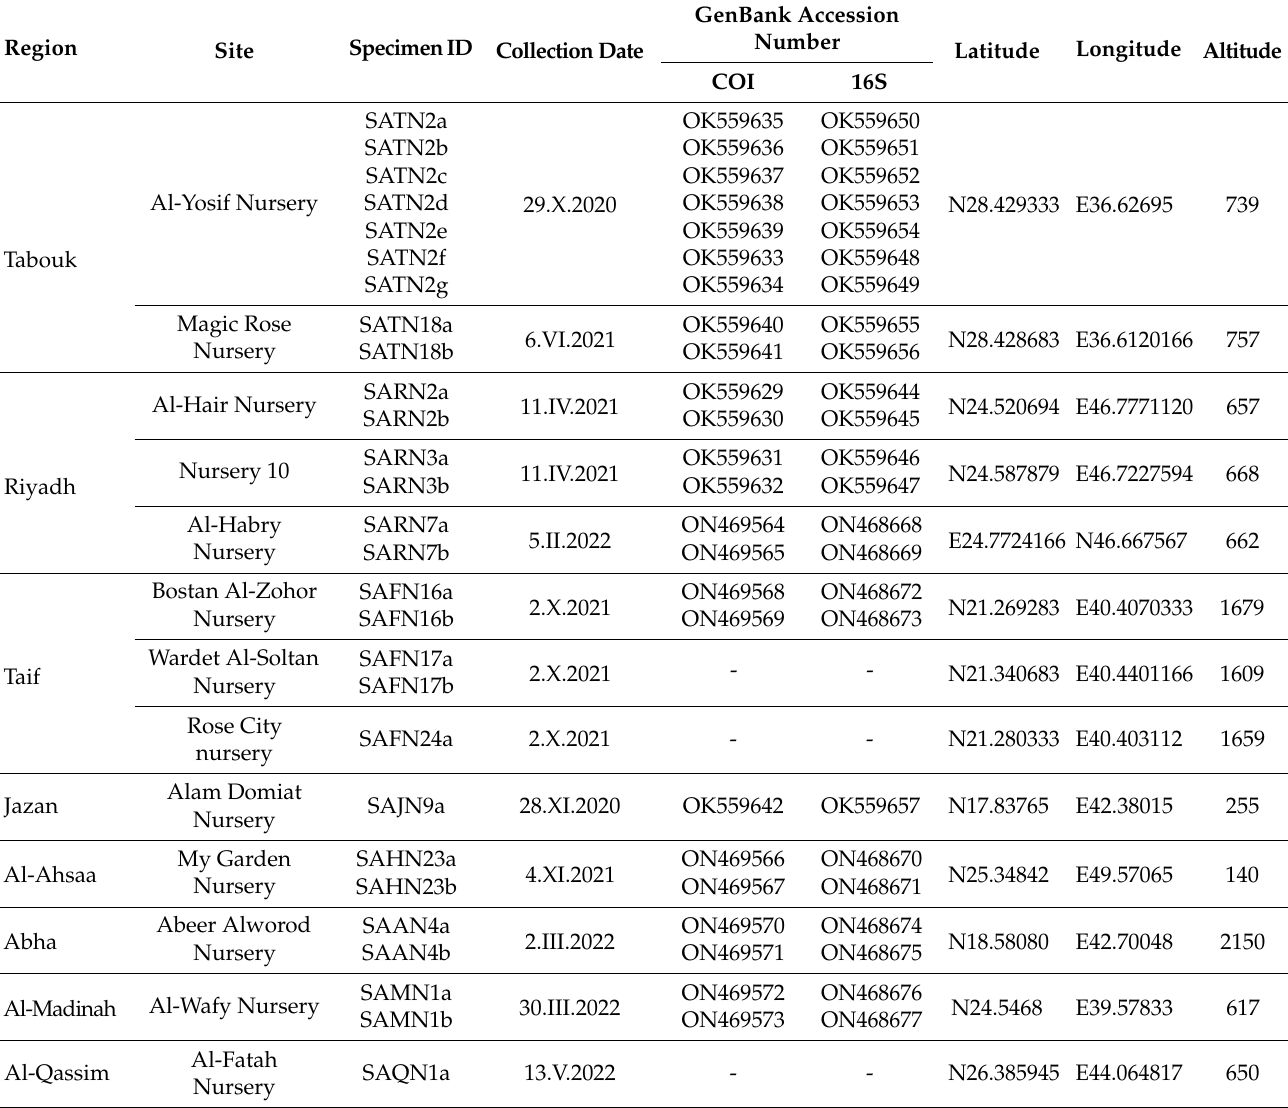
Table 1. Sampling data and GenBank accession numbers for Macrochlamys indica specimens collected from different locations in Saudi